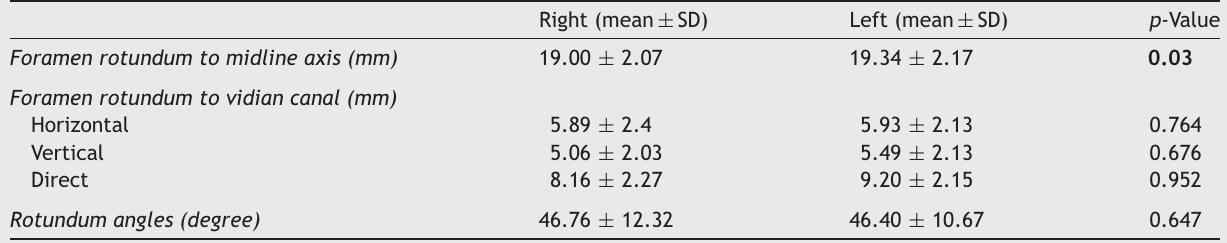
Measurements index of foramen rotundum distances toward midline axis, vidian canal and base of lateral pterygoid plate. Right (mean ± SD) Foramen rotundum to midline axis